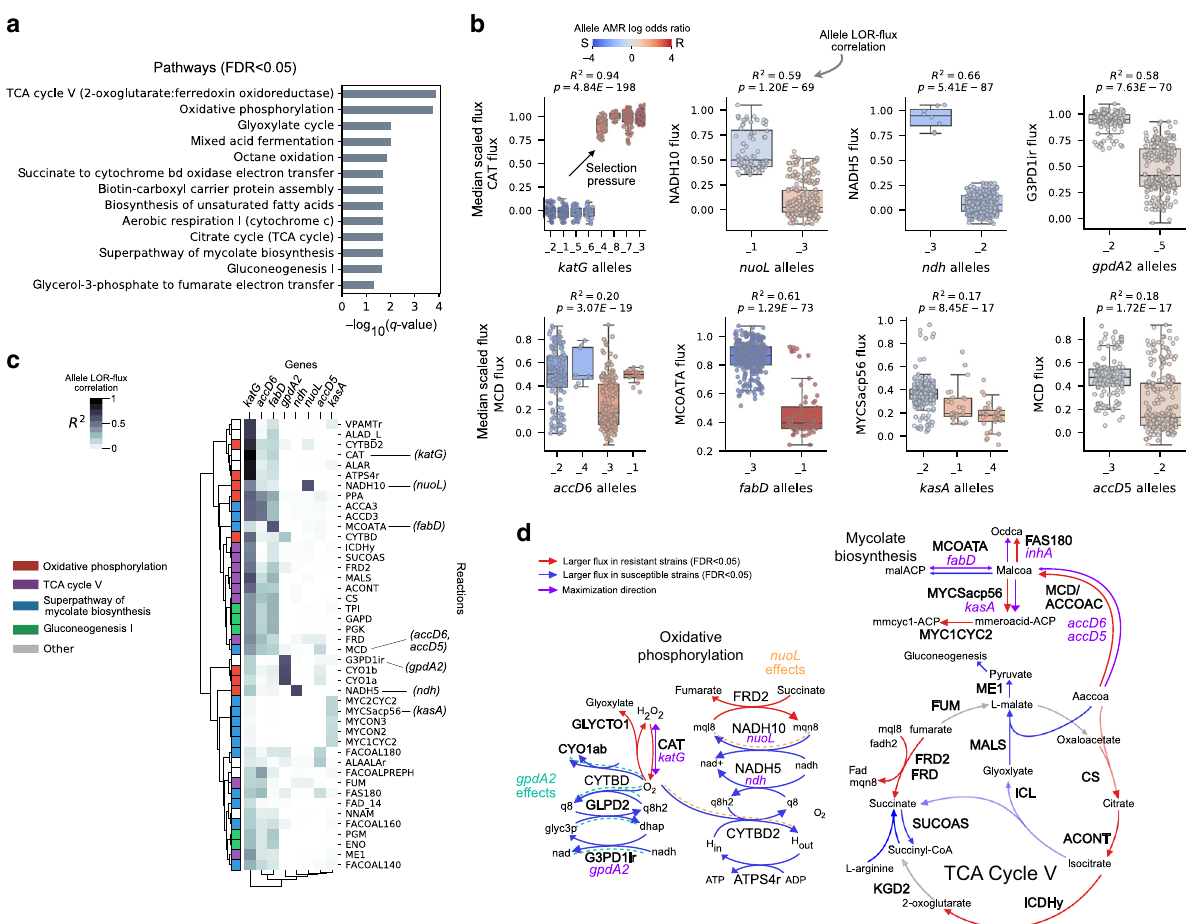
Fig. 5 Characterization of isoniazid MACs. a Horizontal bar plots of pathways enriched with signi fi cant isoniazid-associated fl uxes with FDR < 0.05. b Boxplots of katG, nuoL , ndh , gpdA2 , accD6 , fabD , kasA , and accD5 allele-speci fi c fl uxes for the reactions catalyzed by their gene-products. Alleles are rank ordered from least to greatest by their log odds ratio (LOR), from left to right. The fl ux ( y -axis) is the median scaled fl ux across the high-quality isoniazid MACs. The boxes are colored according to the allele LOR, where positive corresponds to resistant (R) dominant while negative corresponds to susceptible (S) dominant. The box shows the quartiles of the dataset with the median noted as the horizontal line while the whiskers extend to show the rest of the points with outliers colored gray. The R -squared and P -value for the regression between allele LOR and fl ux is noted. See Supplementary Data 5 for list of mutations per allele. c Clustered heatmap of allele LOR- fl ux correlations for signi fi cant reactions in TCA Cycle V, Oxidative phosphorylation, and Mycolate biosynthesis. d Pathway depiction of TCA Cycle V, Oxidative phosphorylation, and Mycolate biosynthesis. Signi fi cant allelic effects are shown by dashed lines and colored for gpdA2 and nuoL